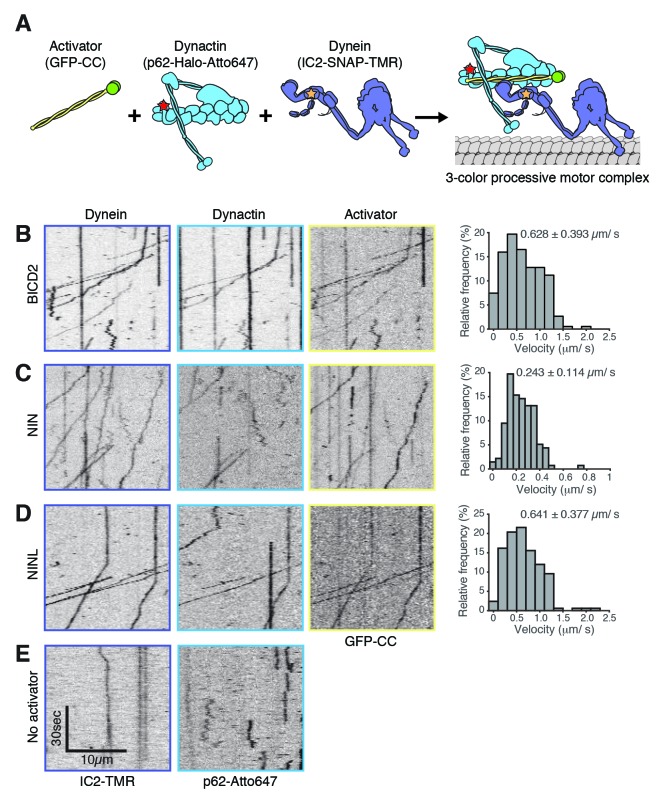
NIN and NINL are novel activators of dynein/dynactin motility.(A) A schematic of the components added to the single-molecule motility assay. Dynein (IC2-TMR; yellow star), dynactin (p62-Atto647; red star) and GFP-tagged (green spheres) activators (BICD2) or candidate activators (NIN and NINL) were purified separately, mixed, and the motility of the complex along microtubules was monitored by nearly simultaneous three-color TIRF microscopy. (B-E﻿).ymographs of each imaging channel (left) and velocity histograms (right) with mean velocity (± S.D.) are shown, n is greater than 146. NIN had a slower velocity in this assay compared to Figure 4G. This could be due to the lack of post-translational modifications in proteins expressed in E. coli; future work will be required to understand this. Data shown is analyzed from one technical replicate, although two technical replicates were collected for each activator and displayed similar trends.